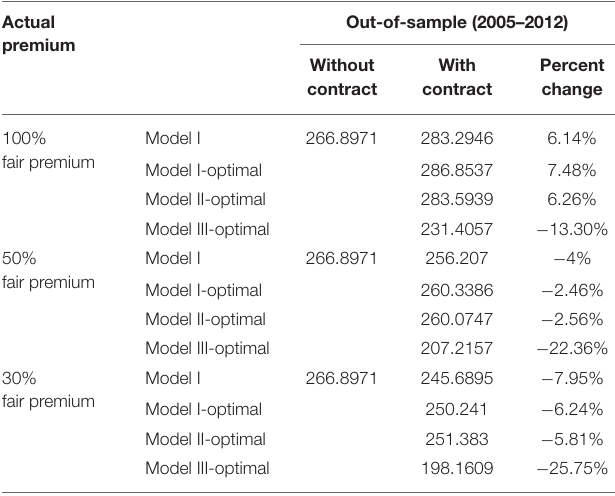
TABLE 8 | The efficiency of the WII contract as Measured by Mean Root Square Loss (MRSL). Actual